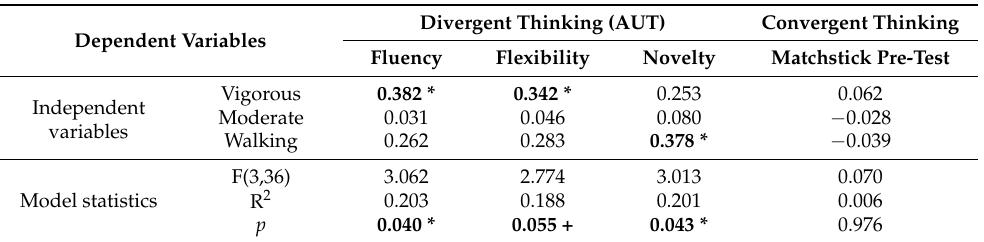
Table 1. Multiple linear regression results using intensity-specific regular PA to predict creative thinking at